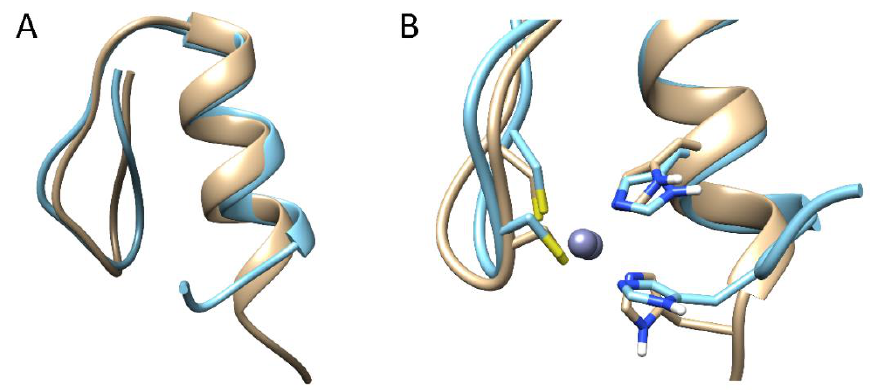
Figure 3. CP1-1991 (brown) and CP1-2015 (cyan) representative structures from cluster analysis per- formed over structures extracted from minimum energies from the FES. In ( A ), the Zn(II) ion was omitted for clarity and the full peptide sequence was shown, while ( B ) shows a zoomed region of the Zn(II) binding site.